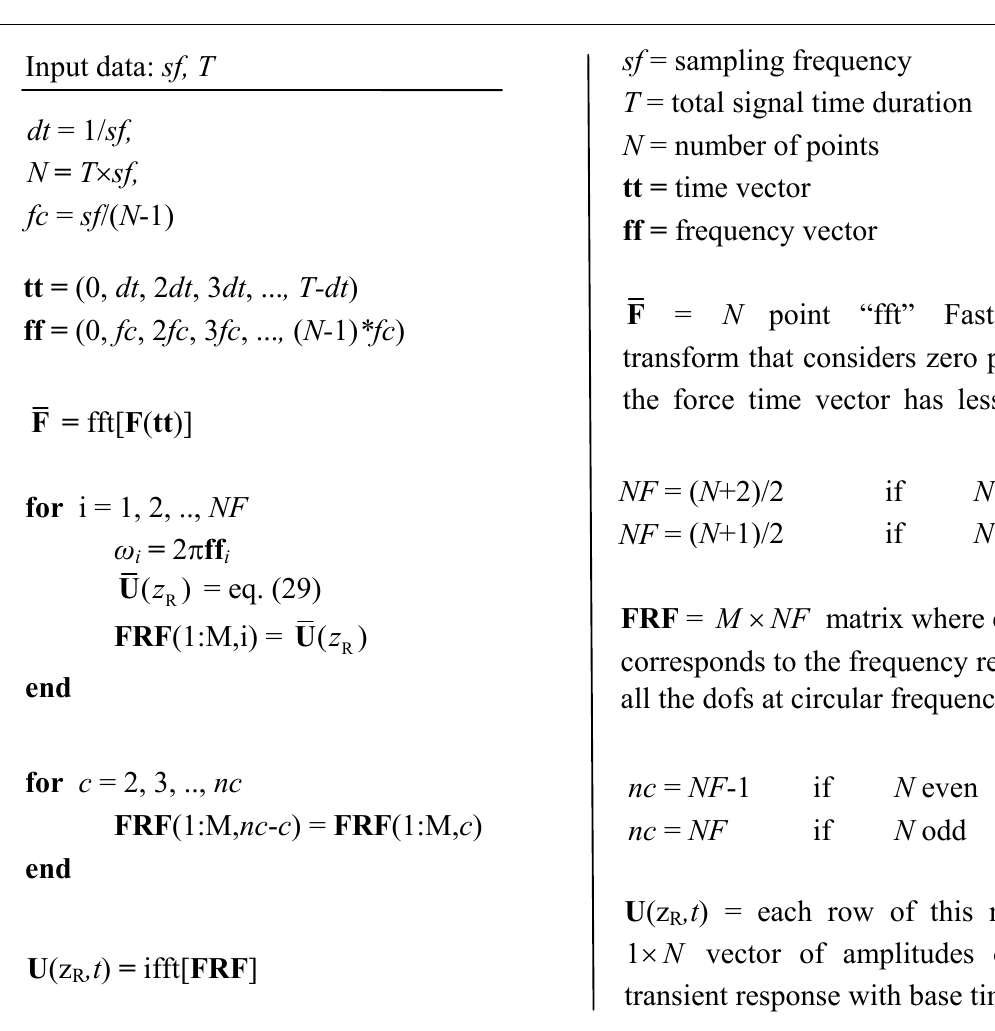
Figure 3 . Schematic flowchart of the numerical